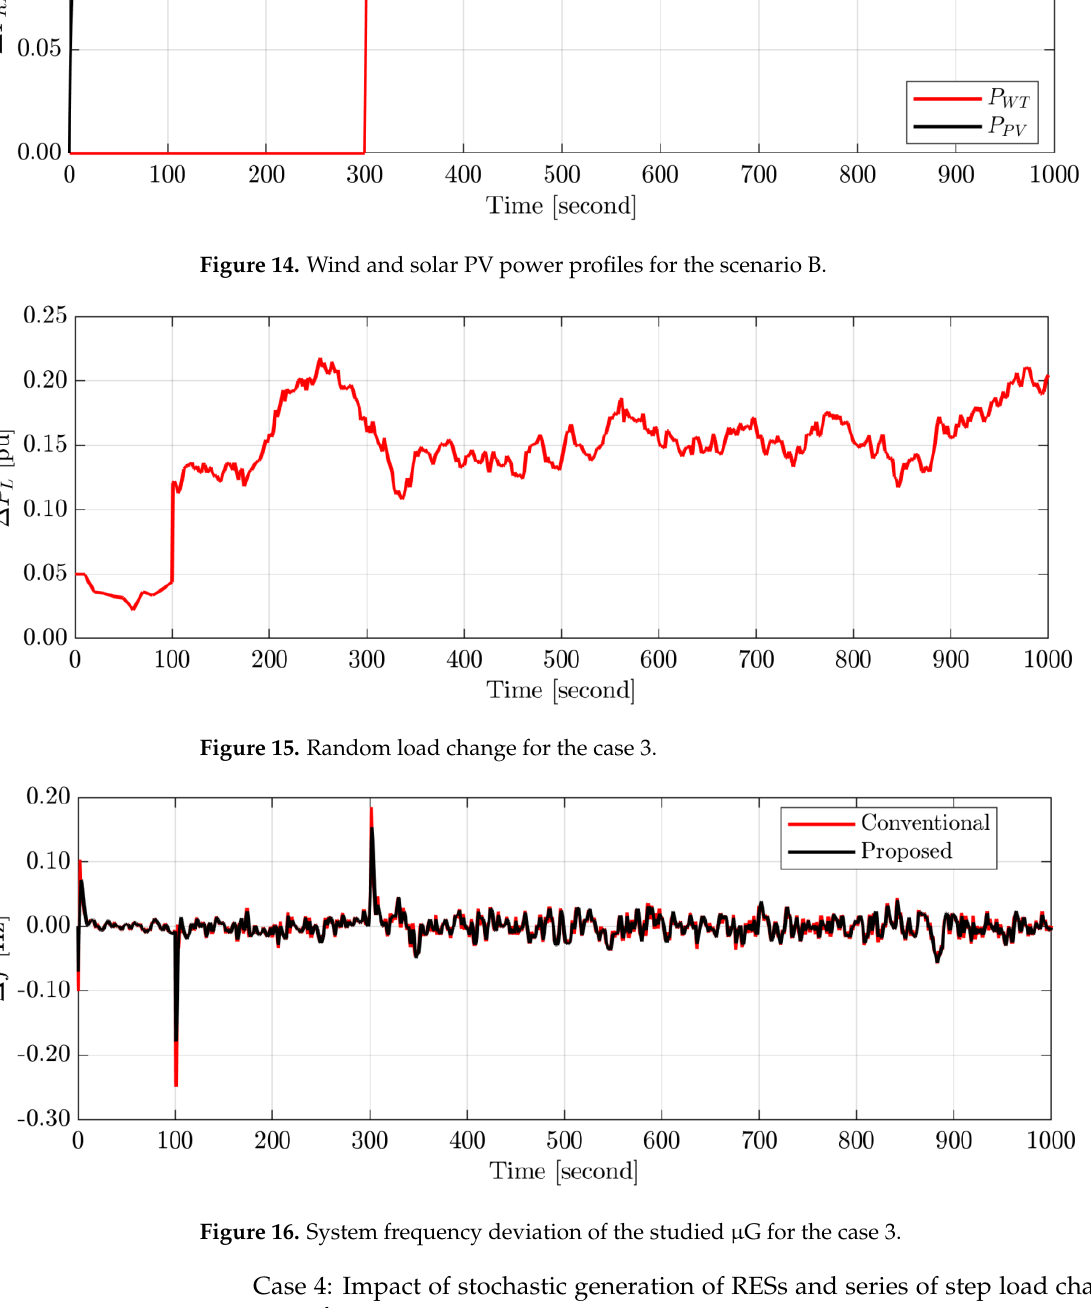
Figure 16. System frequency deviation of the studied µG for the case 3.